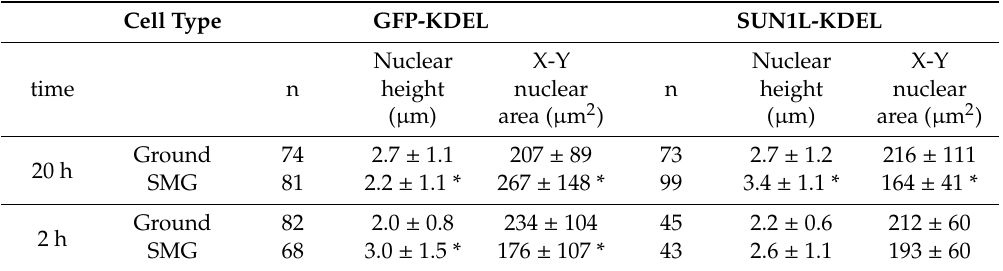
Table 1. Nuclear morphology: After 20 h exposure to SMG, the nuclear height decreased in GFP-KDEL cells, while the height increased in SUN1L-KDEL cells again indicating a role of the LINC complex in the response of the nuclear shape to SMG. * p < 0.05, comparing same cell line to the 1G condition within the same time-point, statistically significantly di ff erent; the comparisons are with the corresponding 1G control. All values are shown as the mean ± SD.2.2. Short Duration Simulated Microgravity-Induced, LINC-Dependent Changes in Nuclear Shape. Cell Type GFP-KDEL